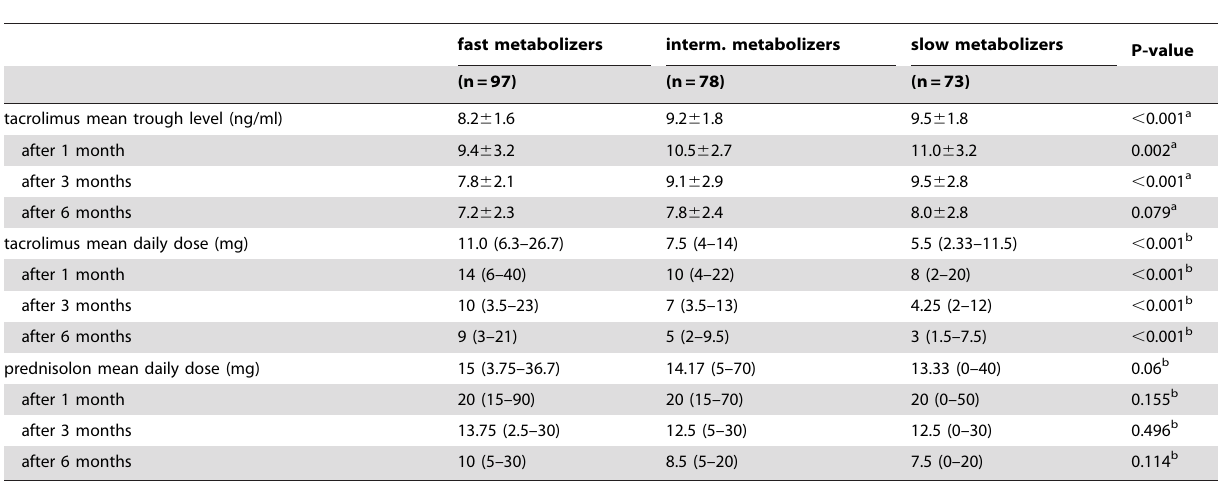
Table 2. Medication doses and blood trough